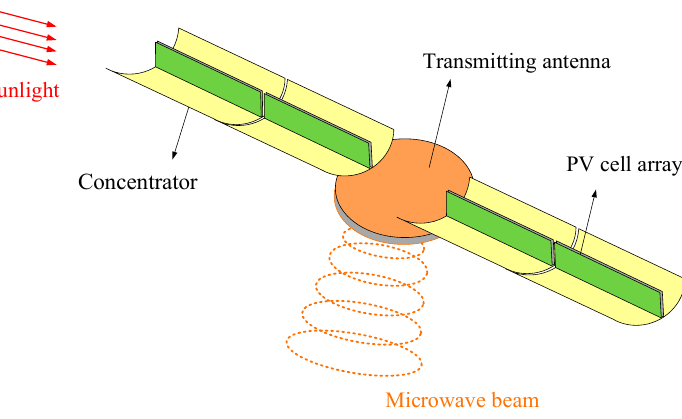
Figure 3. Diagram of the original line-focused SSPS model.